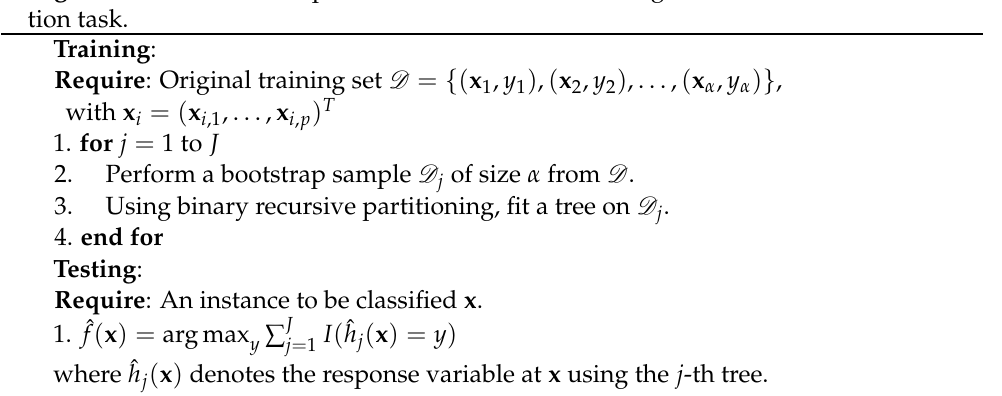
Algorithm 1: A common procedure of random forest algorithm for classifica-